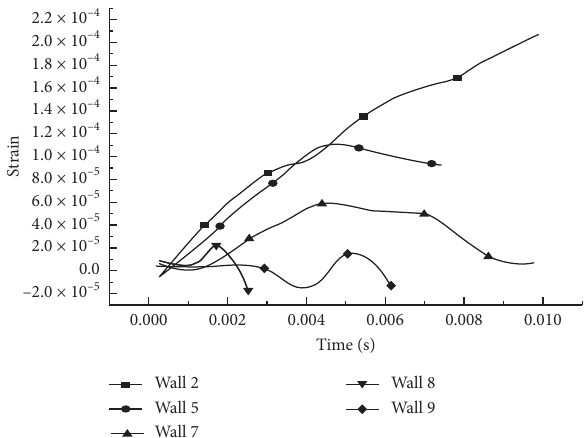
Figure 8: Strain curves of Walls 2, 5, 7, 8, and 9. wall. The overall damage situation of each wall is shown in Figure 9.